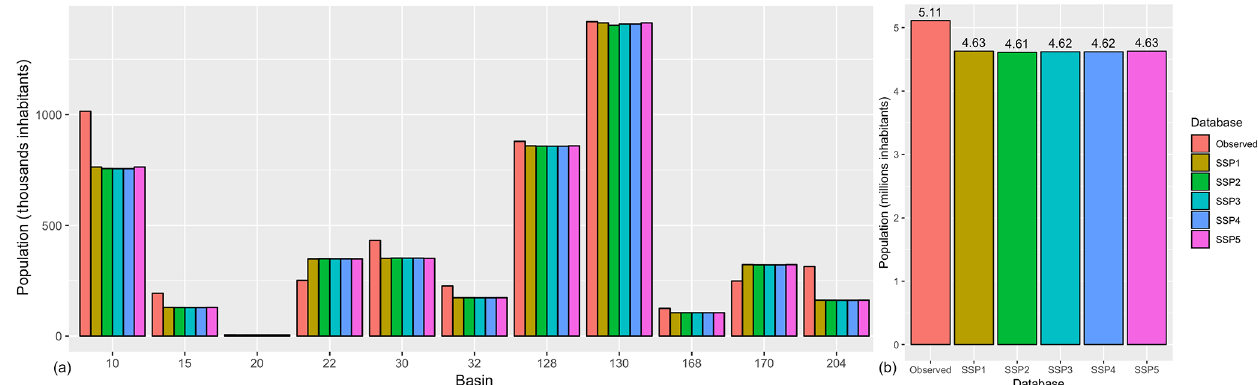
Figure A2. Population (year 2010) for each basin of the Valencian Community (a) and for the whole region (b) for the different databases. The numbers on the x axis indicate the code of each basin (see Table